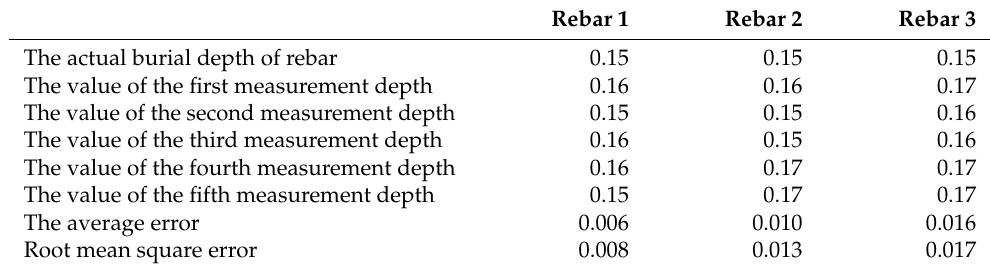
Table 3. Comparison of the depth between the steel bar detected by the ground-penetrating radar real-time detection system and the actual buried depth